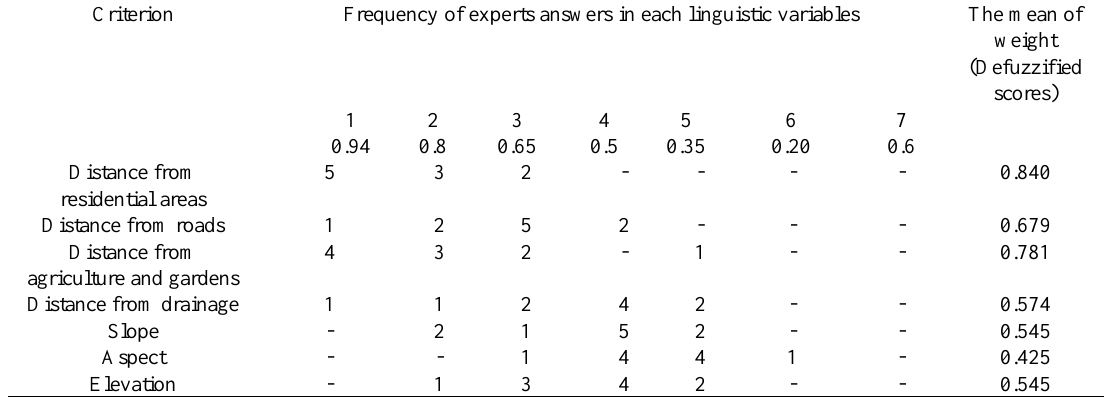
Figure 5. Deforestation risk zoning using fuzzy method Table 4. The weight of each criterion through crisp scores of fuzzy